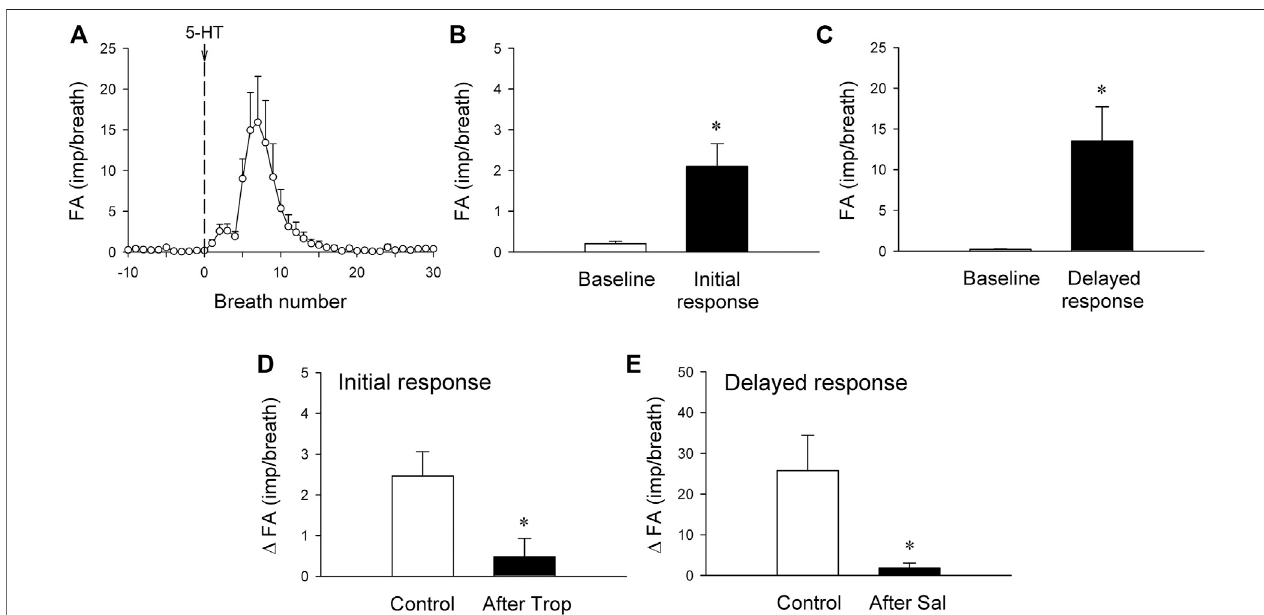
FIGURE 5 | (A) histogram showing average responses of silent RARs to i. v. bolus injection of 5-HT recorded from 21 fi bers in 18 anesthetized, vagotomized, open-chest, and mechanically ventilated rats. Fiber activity (FA), measured on a breath-by-breath basis, revealed that the responses of silent RARs to the i. v. injection of 5-HT (16 μ g/kg; vertical line) consisted of two distinctly separate phases: the initial (B) and delayed phases (C) (see experimental record in Figure 4C ). Δ FA for the initial response was measured as the difference between the baseline FA (20-breath average) and the peak FA (average of the fi rst 3 breaths occurring after the 5-HT injection); Δ FA for the delayed response as the difference between the baseline FA (20-breath average) and the peak FA (average of 5 consecutive breaths) during the fi rst 4 – 20 breaths. (D) The initial response to 5-HT before and 15 min after pretreatment with Trop (15 μ g/kg; n = 6 from 6 rats). (E) The delayed response to 5-HT before and 10 min after pretreatment with Sal (0.5 mg/kg; n = 6 from 5 rats). *, signi fi cantly different ( p < 0.05) from the baseline in (B,C) or control response in (D,E) . Data are means ±